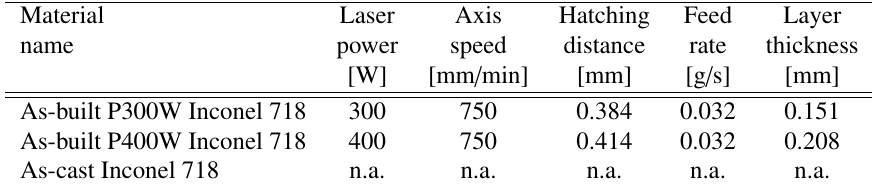
Table 1: Inconel 718 alloys studied in this research. Data from [2]